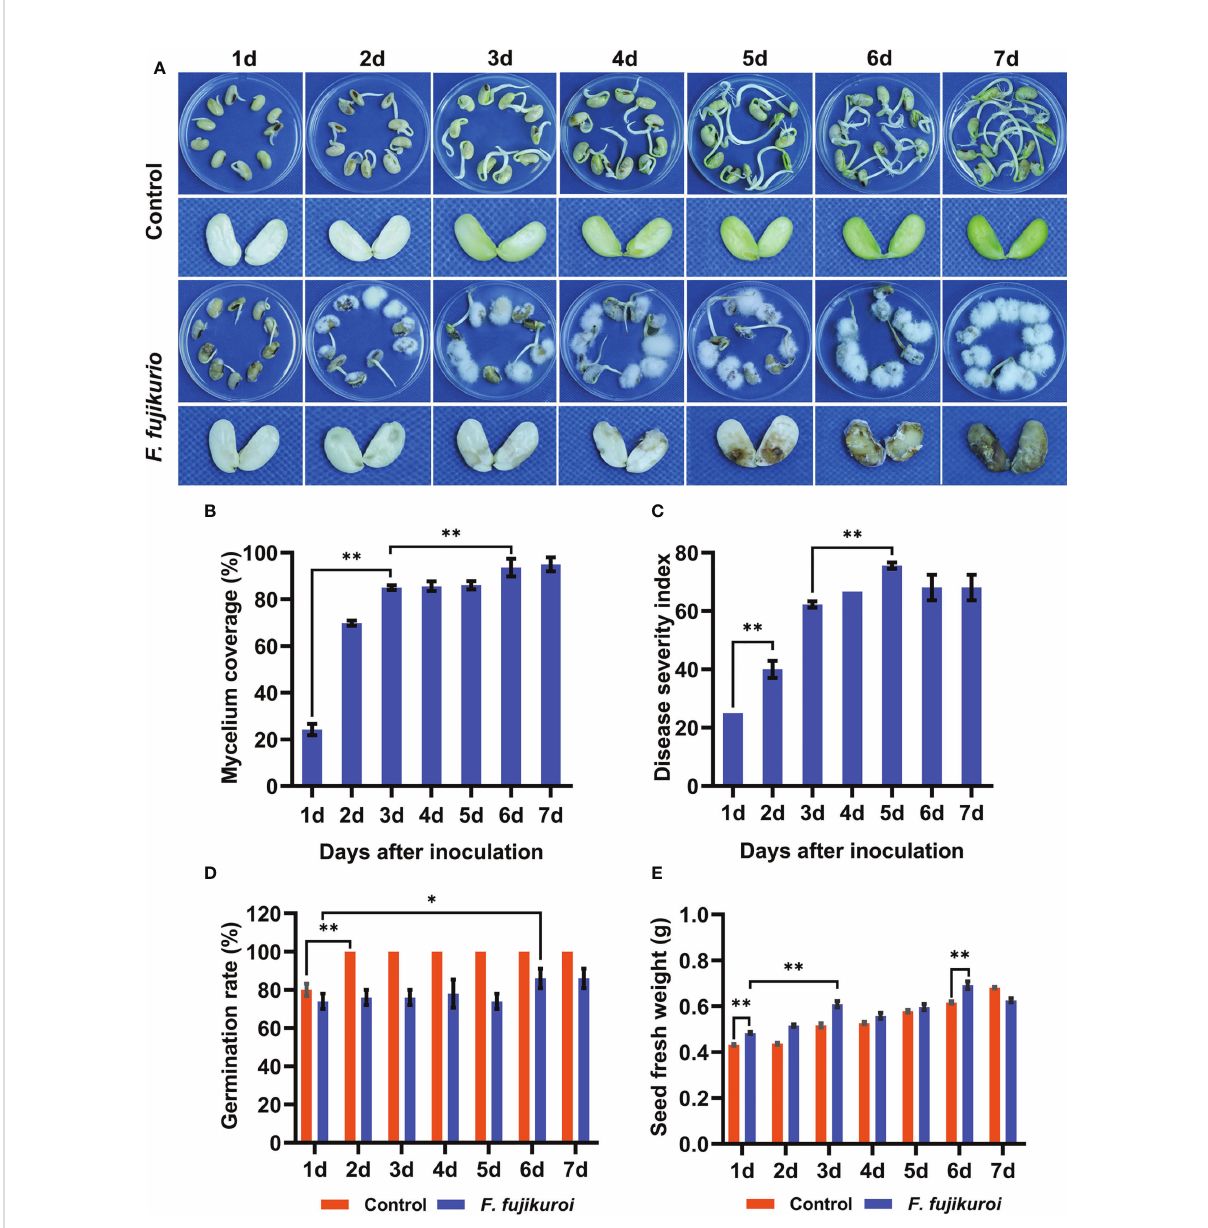
FIGURE 1 Symptoms of seed rot caused by F. fujikuroi and related seed parameters. (A) Time-course symptoms of soybean seeds with or without F. fujikuroi inoculation were observed over time. (B) Percentage of mycelium coverage was calculated by the coverage area of mycelium on the seed surface. (C) Disease severity index (DSI) was evaluated and calculated according to disease symptoms. Germination rate (D) and seed fresh weight (E) of the non-inoculated and inoculated seeds with F. fujikuroi were recorded over the inoculation time. Statistical analysis was conducted using Statistical Product and Service Solutions (SPSS) version 23.0 with the ANOVA method; ** indicates signi fi cant difference at the level of p = 0.01, while * stands for signi fi cant difference at the level of p = 0.05. Each treatment contains fi ve plates with 10 seeds on each plate (n = 50), and three independent experiments were